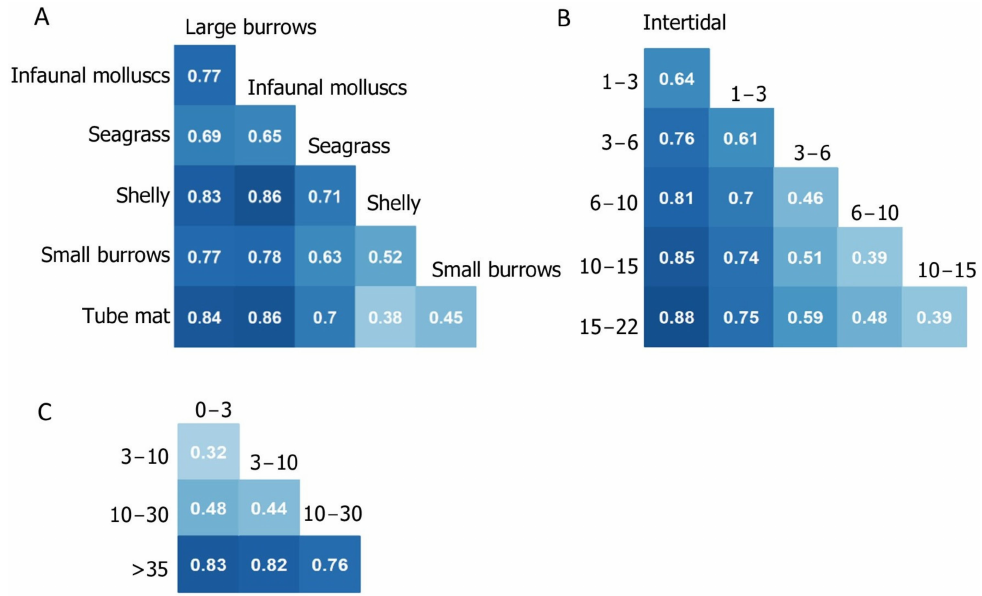
Figure 6. Jaccard’s dissimilarity matrices for ( A ) habitat type, ( B ) water column depth (m) and ( C ) ediment mud content